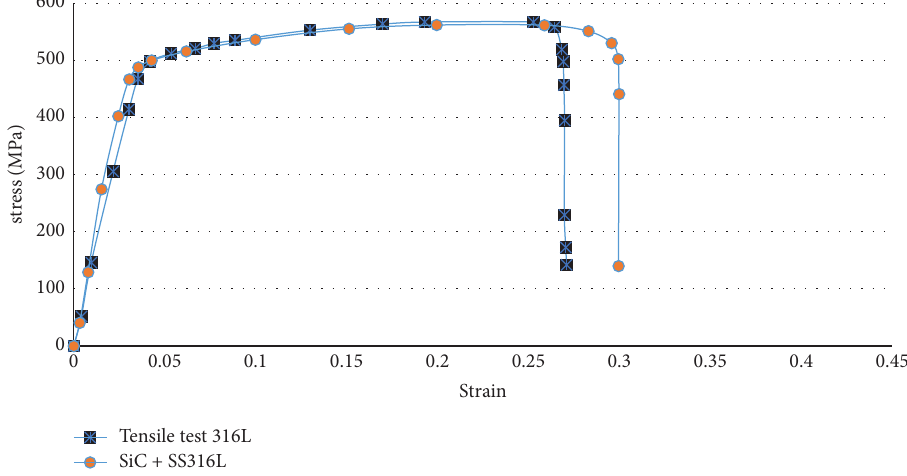
Figure 11: Tensile strength for breaking the samples 316L and 316L with 1%